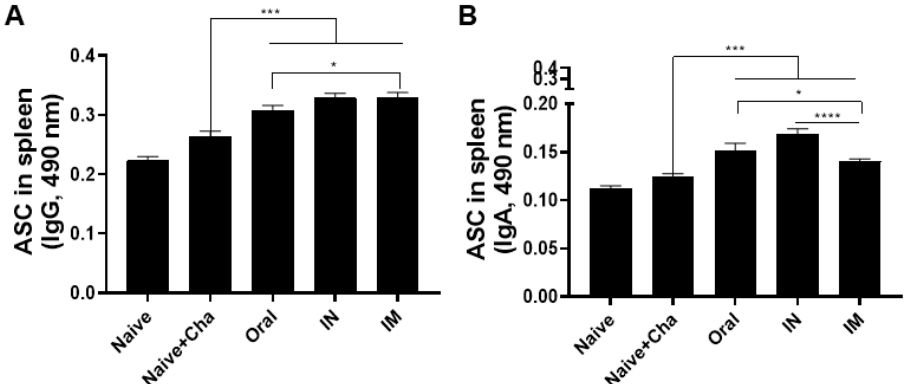
Figure 4. Splenocytes were co-cultured with T. gondii antigens and antibody-secreting cell responses were evaluated. T. gondii -specific IgG ( A ) and IgA ( B ) ASC responses were quantified by ELISA. Data are presented as mean ± SD and asterisks indicate statistical differences between groups. (* p < 0.05, *** p < 0.001, **** p < 0.0001). All samples were acquired on an individual basis and a total of three independent experiments were performed in